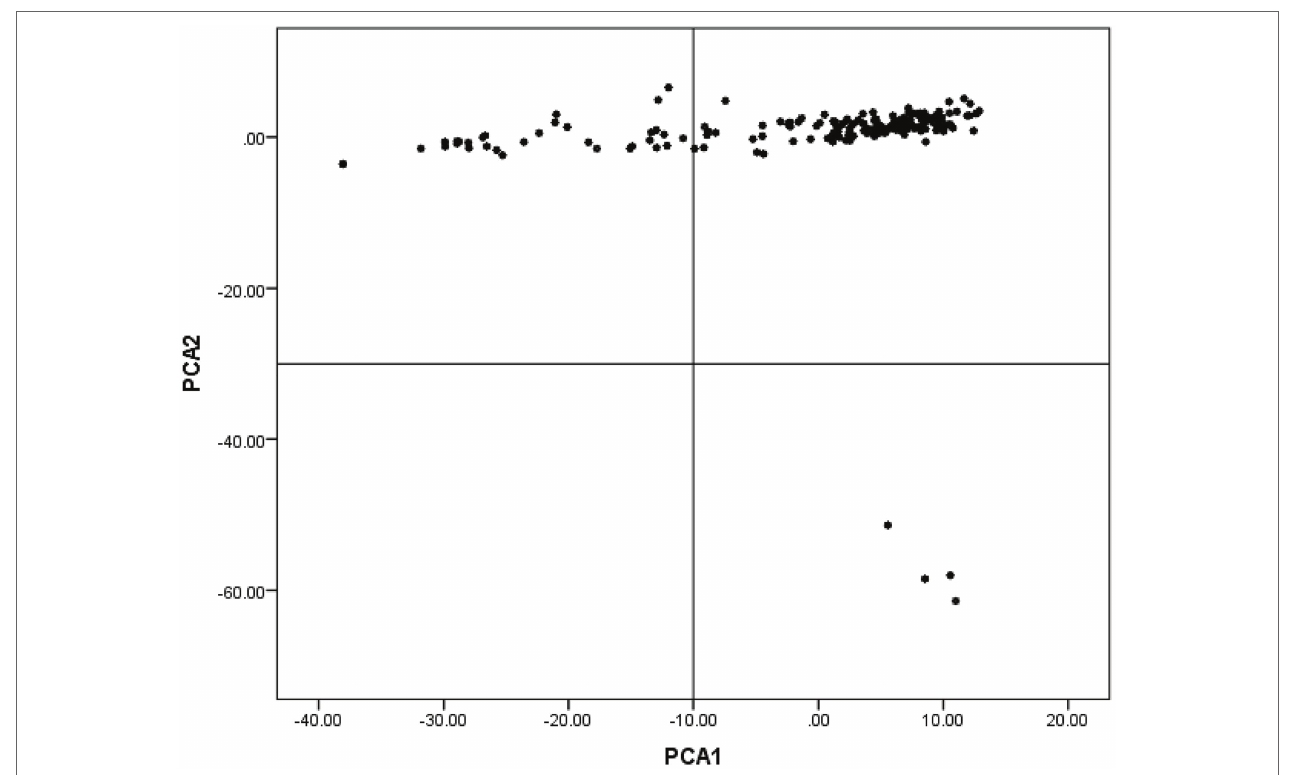
FIGURE 1 | Population structure revealed by multidimensional scaling (MDS) analysis in indigenous chicken (IC) in